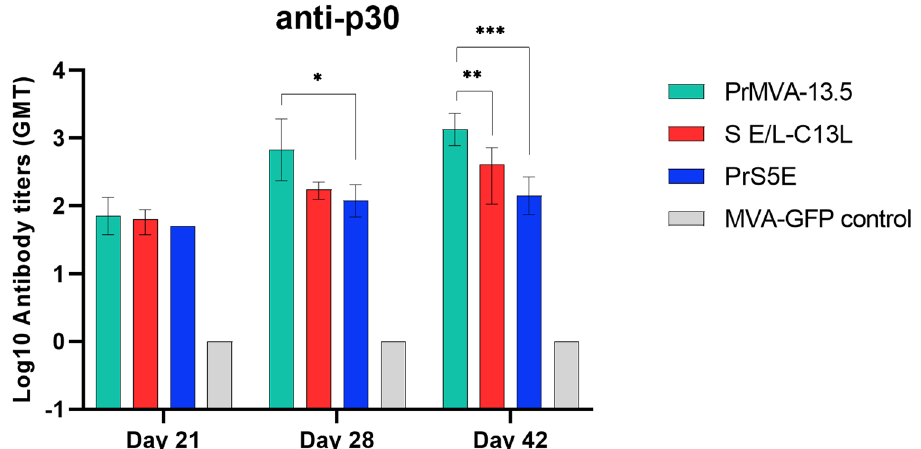
Figure 7. Characterization of serum samples obtained from mice vaccinated with MVA-p30 constructs. BALB/c mice were primed and boosted (days 21 and 35) with either MVA-PrMVA-13.5L-p30, MVA-S E/L- C13L-p30, MVA-PrS5E-p30, or MVA-GFP. Purified p30 protein (baculovirus-expressed) were used as coating antigen for ELISA assays. Detection of specific anti-p30 antibodies at days 21, 28, and 42 p.i. for all animal groups are shown (n = 4 mice per group). Statistically significant differences between antibody titers are shown (P < 0.05, one-way ANOVA with Tukey’s multiple comparison test) *P < 0.05; **P < 0.005; ***P <